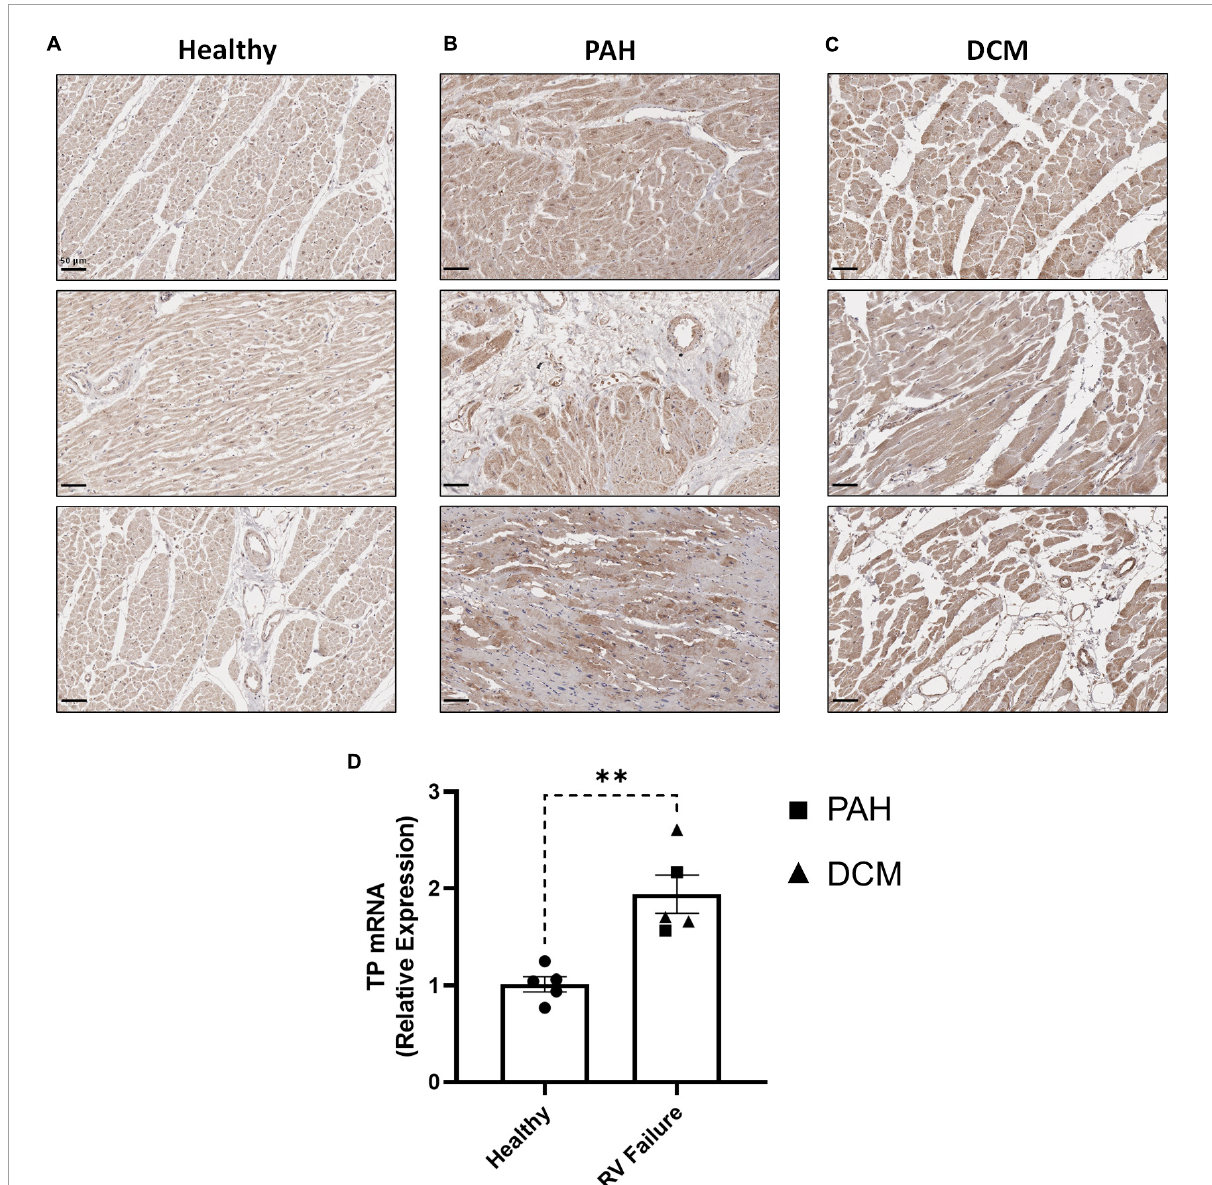
FIGURE7 RV expression of the TP in human PAH and other RV pathologies. (A–C) show three representative photomicrographs of anti -TP-stained human RV tissue obtained from: (A) Healthy donors; (B) PAH patients, and (C) DCM patients, where all images were captured at 150 × magnification (scale bars represent 50 µ m). (D) Shows relative RV TP mRNA expression levels in Healthy ( n = 5) or RV Failure patients ( n = 5, data for PAH and DCM combined). Data presented are the mean ± SEM. ** P < 0.01 according to unpaired Student’s t